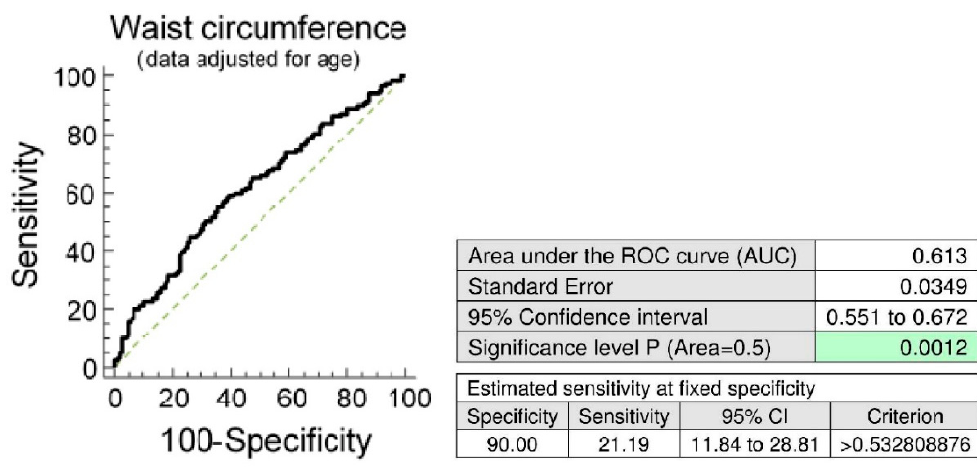
Figure 1. Association between the occurrence of vascular endothelial dysfunction and the central obesity. ( A ) Young and middle-aged women with central obesity (waist circumference values ≥ 80 cm) showed significantly decreased RHI levels when compared with the group of women with normal values of waist circumference (waist circumference values < 80 cm), (unadjusted data: p = 0.006, data adjusted for the age of patients: p = 0.008). ( B ) At 10.0% FPR, a markedly higher proportion of women with waist circumference values above 80 cm had RHI values below cut-off values. 18.64% women before adjustment of the data for the age had RHI values ≤ 1.442. In parallel, 21.19% women after adjustment of the data for the age had significantly lower RHI values.